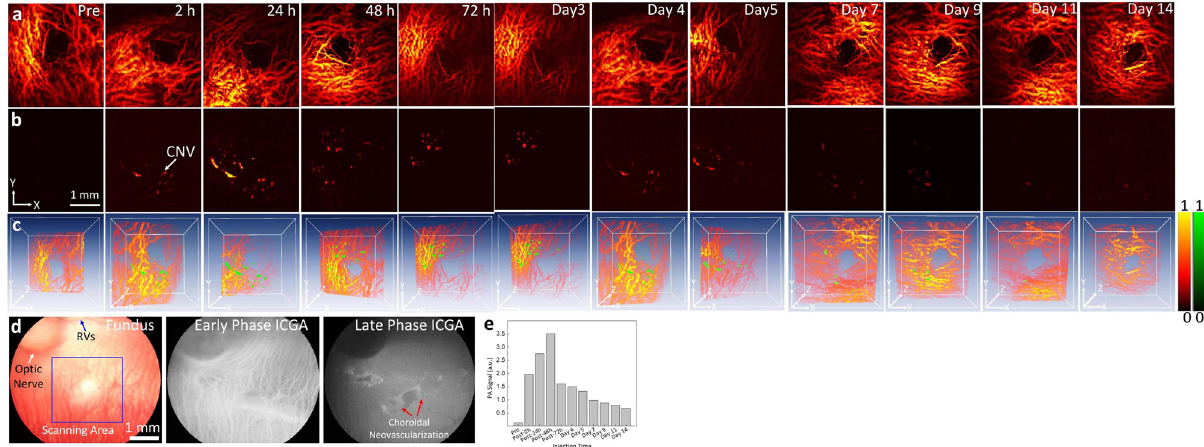
Fig. 8 Study of contrast-enhanced PA detection of CNV model in living rabbits induced by sub-retinal injection. a , b PAM images of CNV obtained along the selected region shown in color fundus image d at 578 and 650 nm, respectively, before and after the injection of CGNP clusters-RGD (0.5 mL at concentration of 2.5 mg/mL). The CNV was obviously distinguished at 650 nm. d Fused 3D visualization of the data set shown in b and c . The retinal vasculature is shown in red and the distribution of CGNP clusters-RGD is shown in green. The color bar represents the normalized image intensities of the control (red) and CGNP clusters-RGD (green). The volumetric acquisition time was approximately 65 s. e PA signals measured for each time points. The error bars represent the standard deviation of the mean PA signals ( N = 3). Source data are provided as a Source Data fi